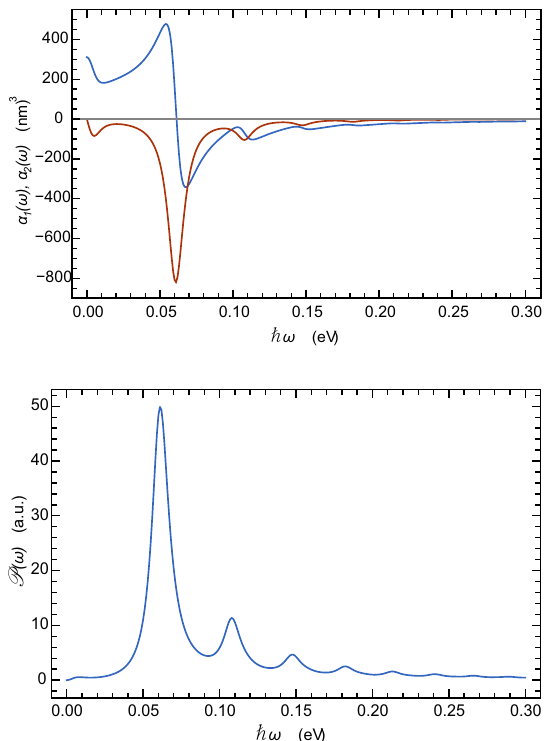
Figure 14. Model 2. Top : Blue line: in-phase component, α 1 ( ω ) , and red line: quadrature component, α 2 ( ω ) , of polarizability in nm 3 , versus photon energy, ¯ h ω . Bottom : Absorbed power in arbitrary units, P ( ω ) , also versus photon energy, ¯ h ω , in eV.